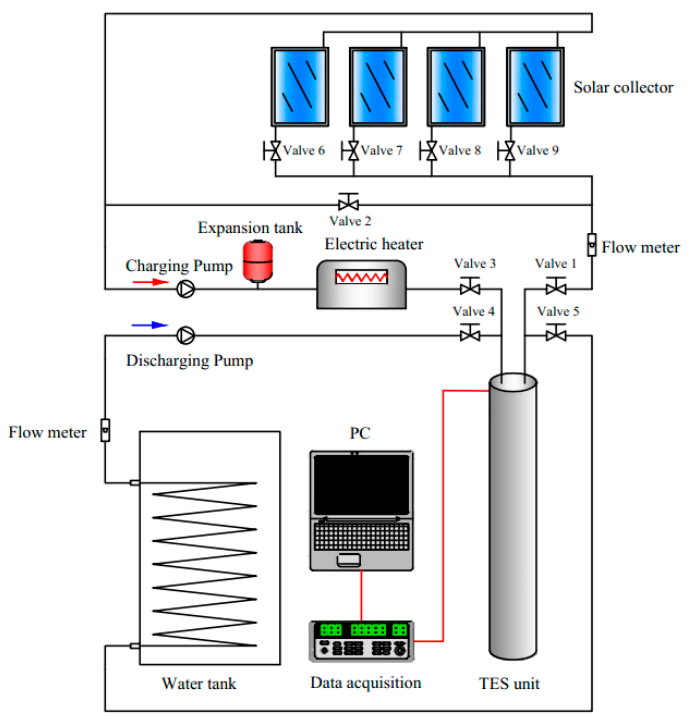
Figure 3. Schematic diagram of the experimental platform ( → charging flow route, → discharging flow route).